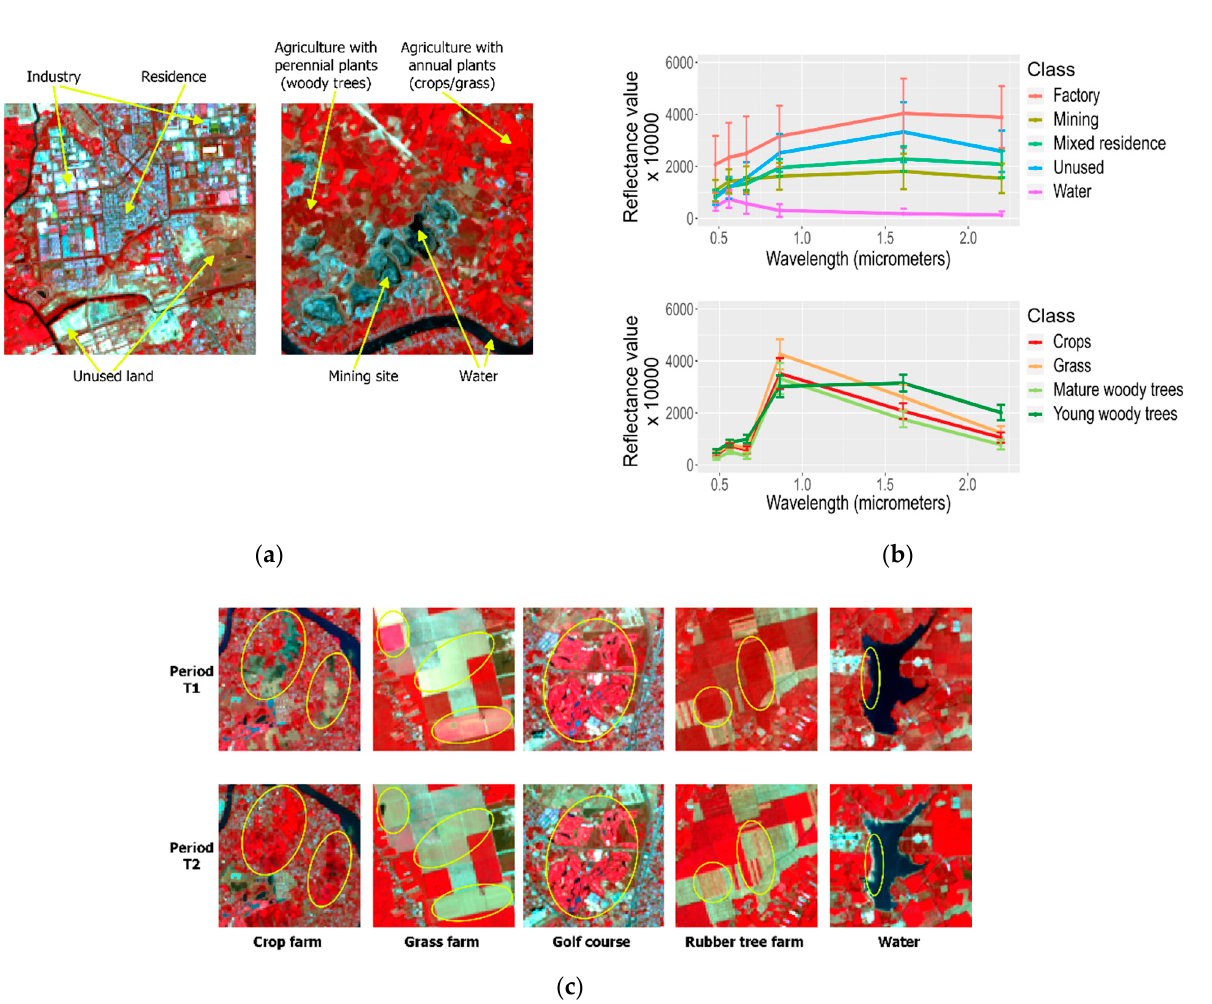
Figure 8. The characteristics of and connection between land cover and land use. ( a ) Spatial and visual characteristics; ( b ) Spectral characteristics; ( c ) Temporal characteristics.